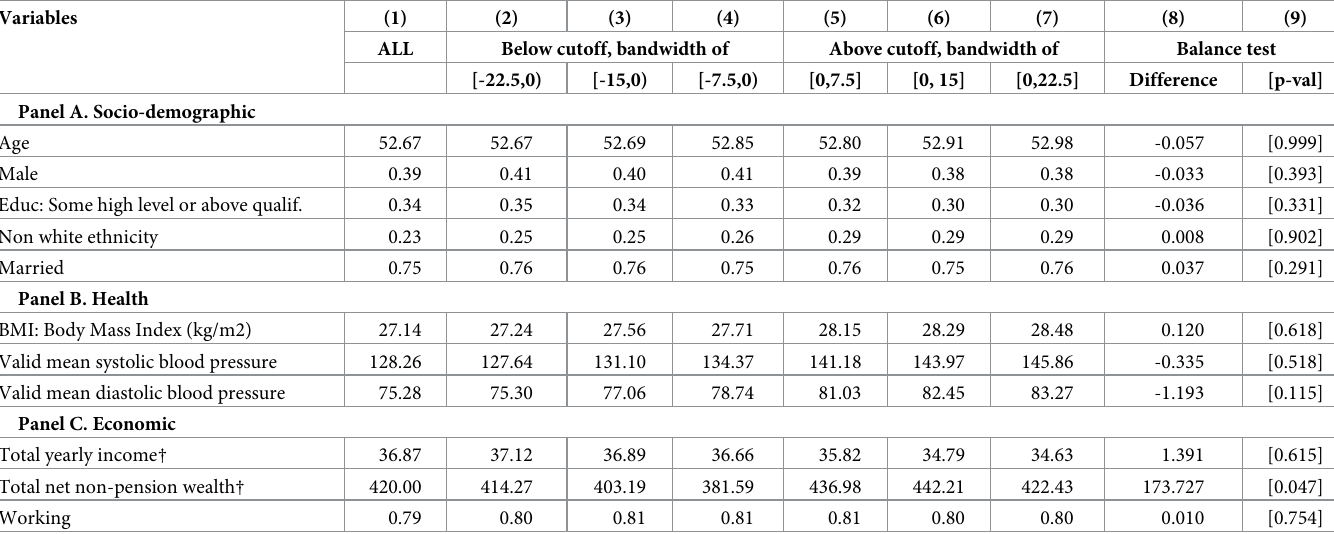
Table 1. Respondents’ characteristics at study entry